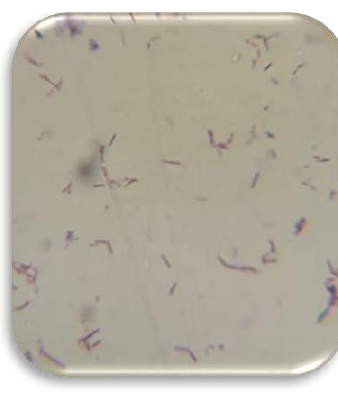
Figure 3. Seed germination using sterile and